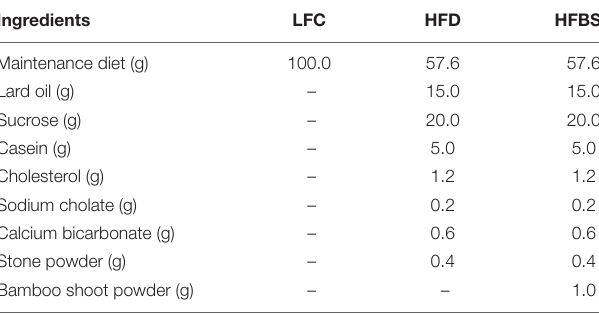
TABLE 1 | Ingredient composition of the experimental